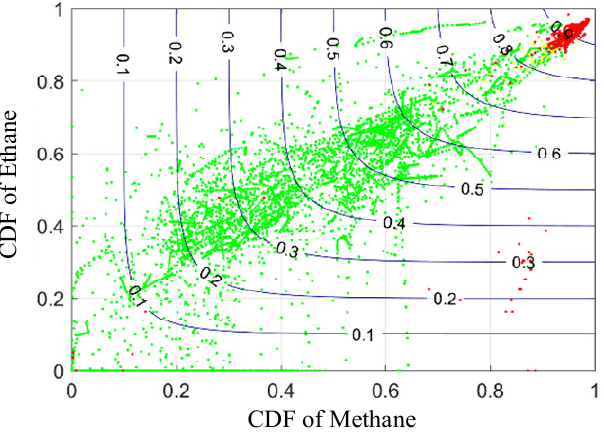
Figure 5. Corresponding relationship between CDF results of the copula functions and three states.